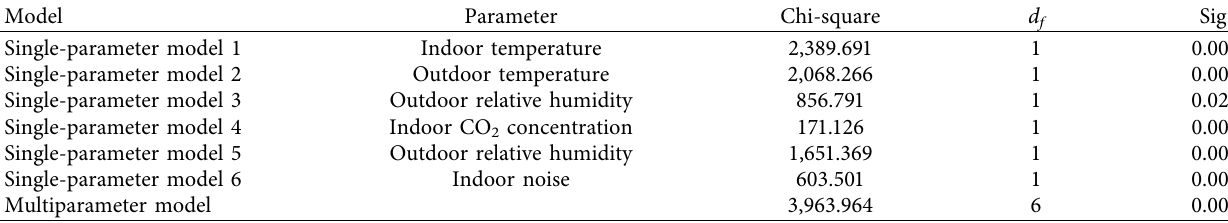
Table 5: Coefficient tests with single and multiple parameters.